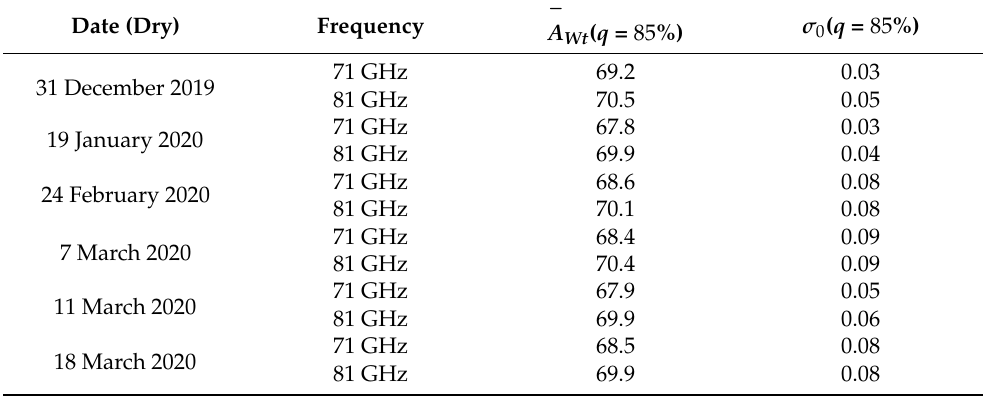
Table 3. Calculated values of A Wt and σ 0 obtained from the data of the considered dry